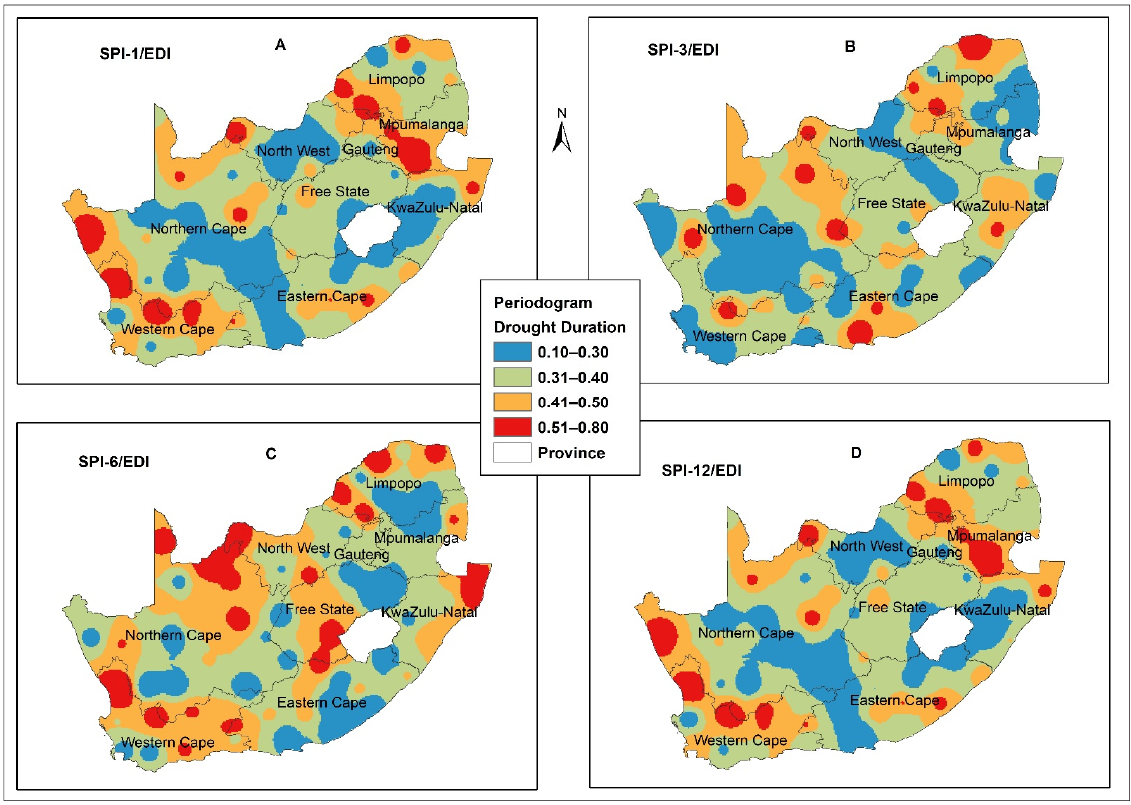
Figure 7. Periodogram dissimilarity measure for drought duration in South Africa. ( A ) SPI-1/EDI; ( B ) SPI-3/EDI; ( C ) SPI- 6/EDI; and ( D ) SPI-12/EDI.